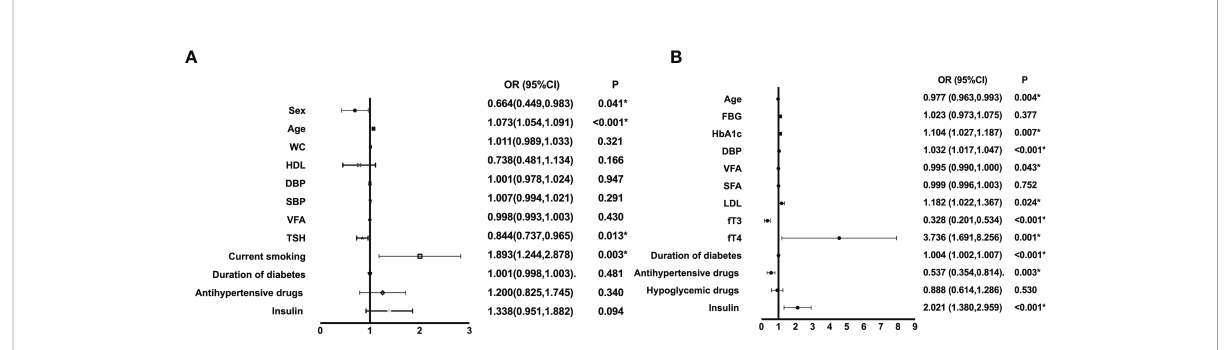
FIGURE 2 Multiple regression analysis of variables independently associated with CA (A) or DPN (B) in all participants. WC, waist circumference; SBP, systolic blood pressure; HDL, high-density lipoprotein cholesterol; FBG, fasting blood glucose; HbA1c, hemoglobin A1c; DBP, diastolic blood